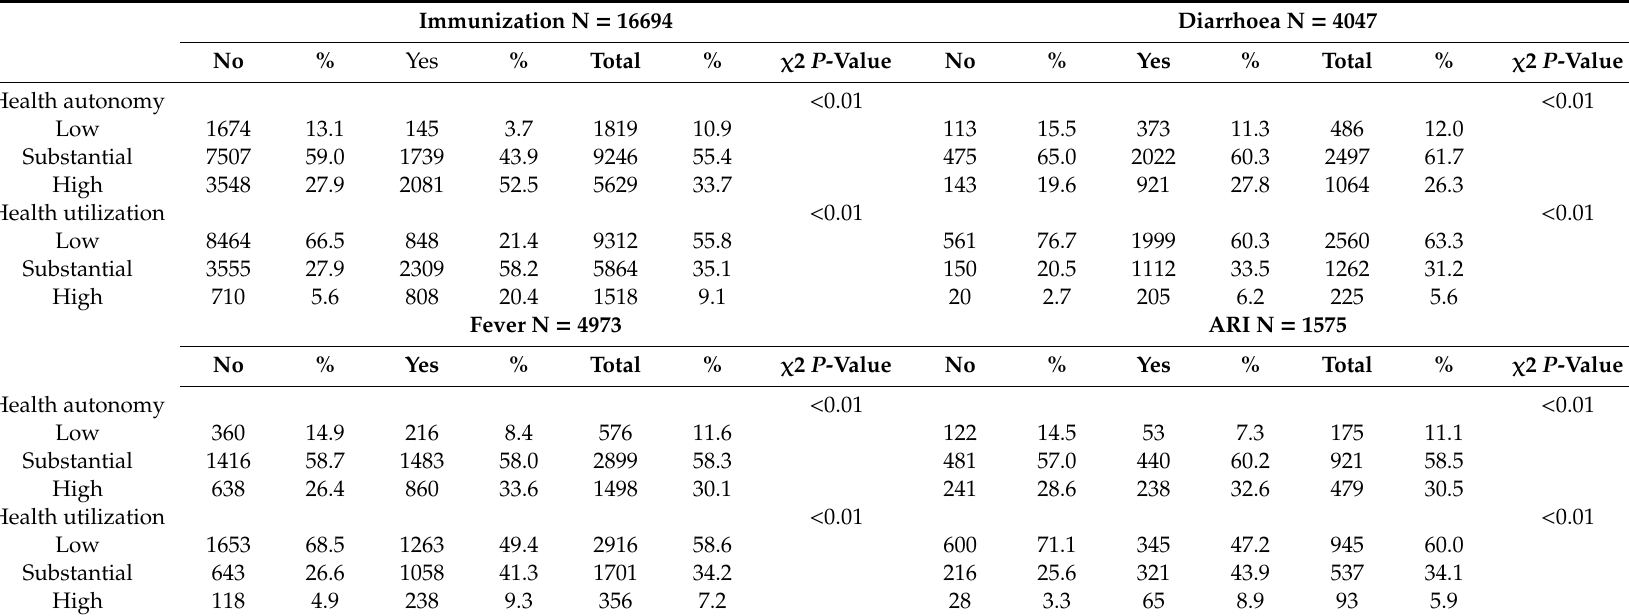
Table 2. Aggregated Cross Tabulation of Independent Variables by Dependent Variables